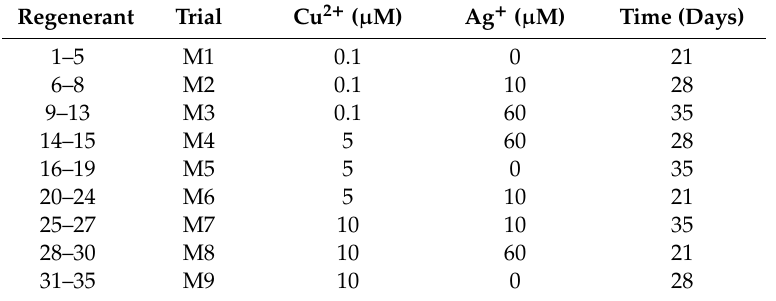
Table 4. Concentrations of ions and number of days adopted in subsequent trials (M1–M9). Regenerant Trial Cu 2 + ( µ